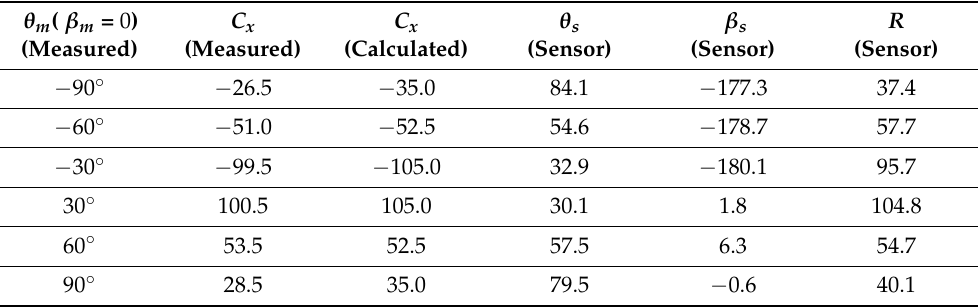
Table 2. Overview of computed and measured sensor data. The centre of the bending circle C x was measured using the ruler as well as calculated from θ m , β m assuming constant curvature. The results indicated by “ sensor ” are the bending amount ( θ s ), the bending direction ( β s ) and the bending radius (R) calculated based on the measured values of l 1 , l 2 and l 3